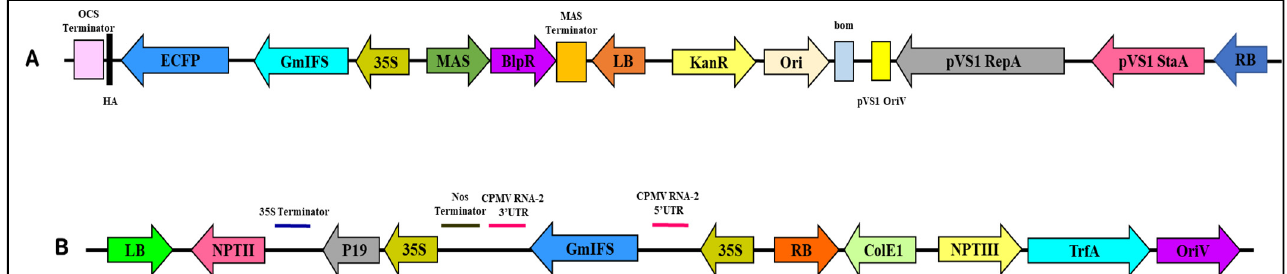
Figure 2. Timeline and diagrammatic representation showing the production of secondary metabolites in plants by transient gene expression.